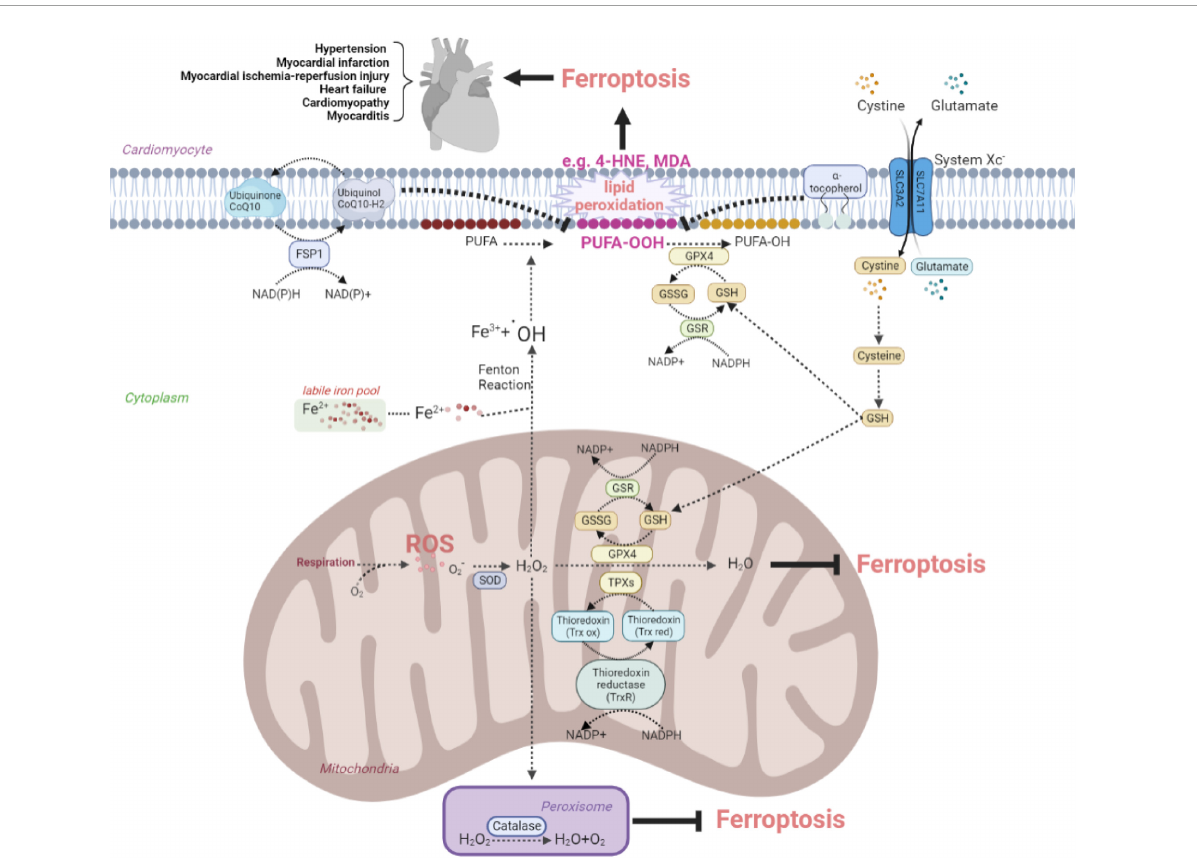
FIGURE1 The anti-oxidative system inhibits ferroptosis to protect against cardiovascular disease by eliminating oxidative stress. The figure shows the protective effects of the SOD family, catalase, Trx recycles, system Xc − -GSH-GPX4 pathway, FSP1-CoQ10-NAD(P)H pathway, and tocopherol on the elimination of ROS and reducing the conversion to lipid peroxide, such as toxic MDA and 4-HNE. ROS, reactive oxygen species; SOD, superoxide dismutase; FSP, ferroptosis suppressor protein; CoQ, coenzyme Q; GSH, glutathione; GSSG, oxidized glutathione; GSR, glutathione reductase; GPX, glutathione peroxidase; 4-HNE, 4-hydroxynonenal; MDA, malondialdehyde; TPX, thioredoxin peroxidase; Trx red, reduced thioredoxin; Trx ox, oxidized thioredoxin; PUFA, polyunsaturated fatty